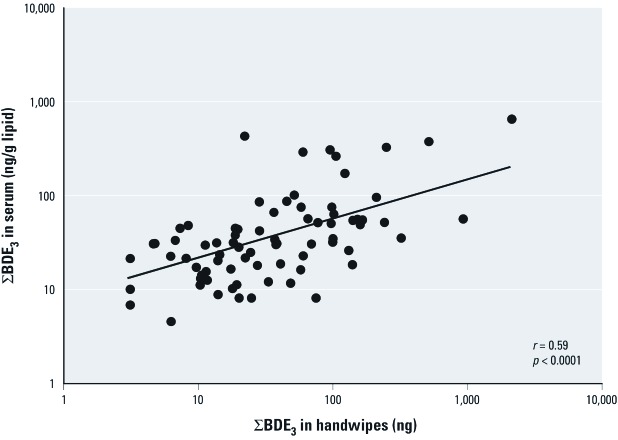
Correlation between serum ∑BDE3 and handwipe ∑BDE3.